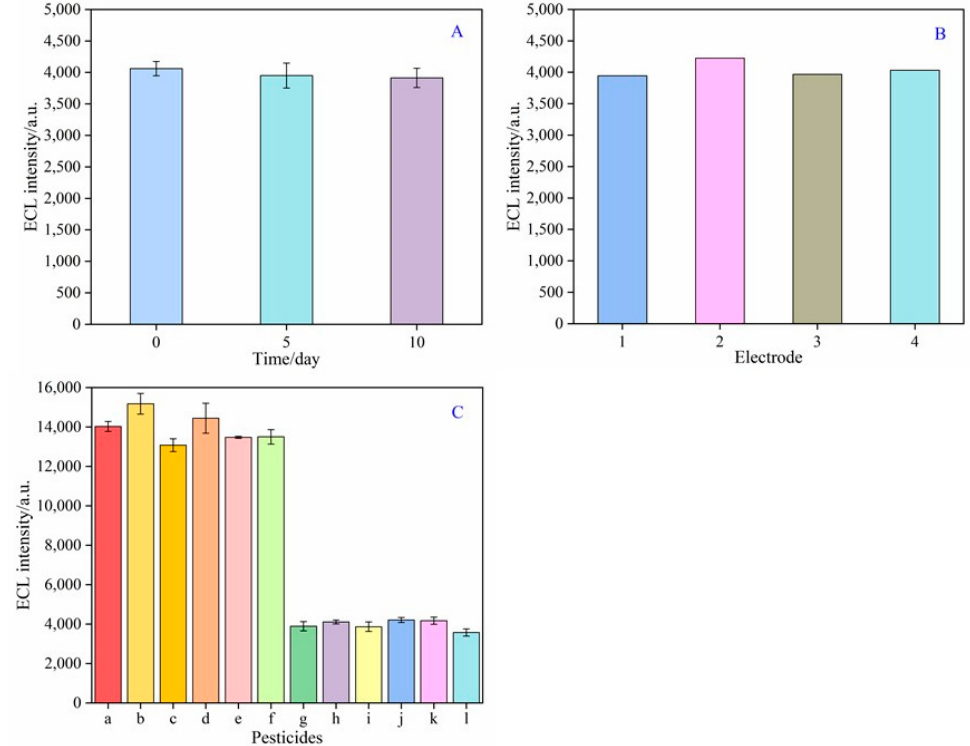
Figure 5. (A) Stability of the aptasensor. (B) Reproducibility of the aptasensor. (C) Specificity of the aptasensor: (a) Simazine; (b) Bromoxynil; (c) 2,4-D; (d) Paraquat; (e) Propanil; (f) Malathion; (g)